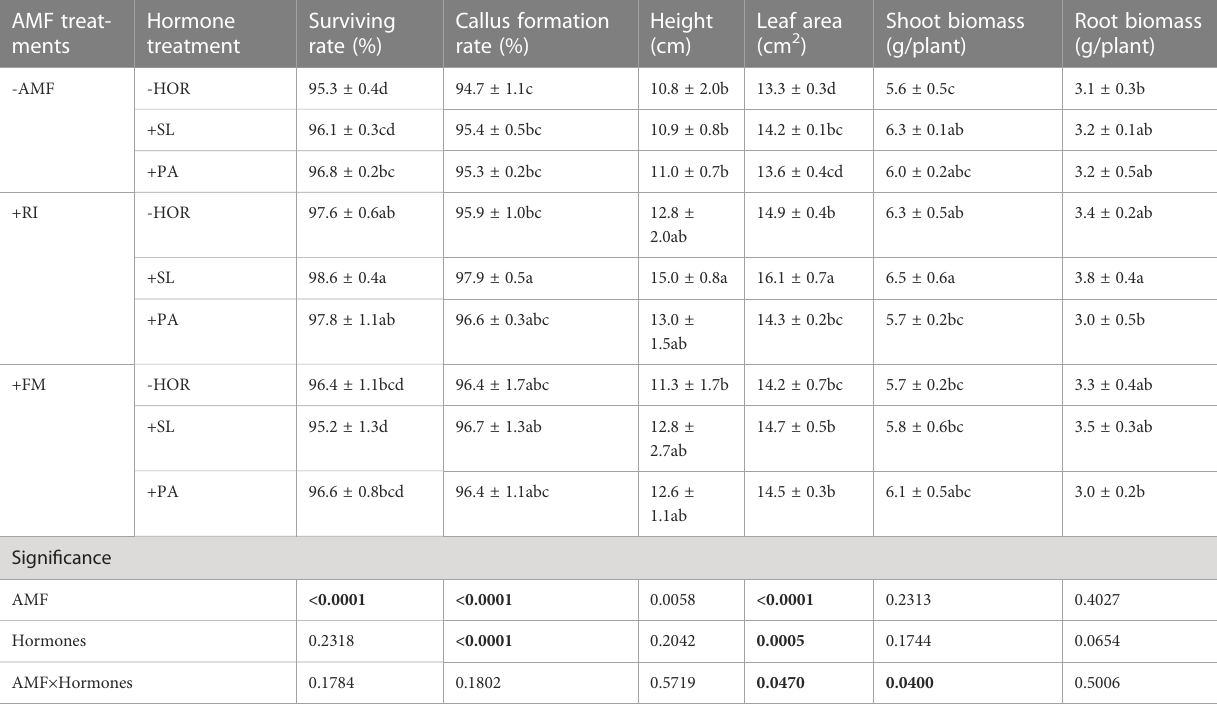
TABLE 2 Effects of AMFs and hormones on the quality and growth of tea cutting seedings. AMF treat- ments